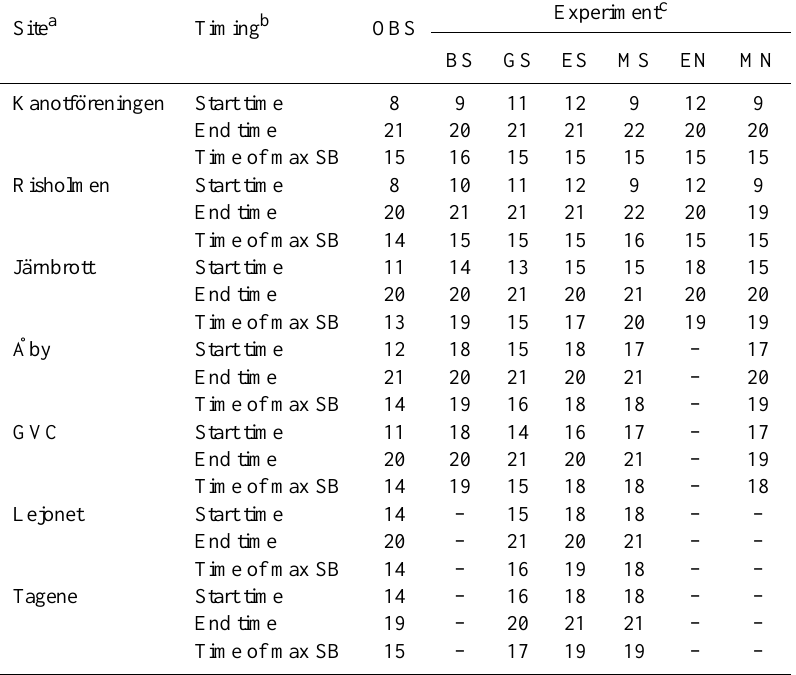
Table 3. Observed (OBS) and simulated sea breeze timing (o’clock) with different experiments at all observational sites on 8 May 2001.